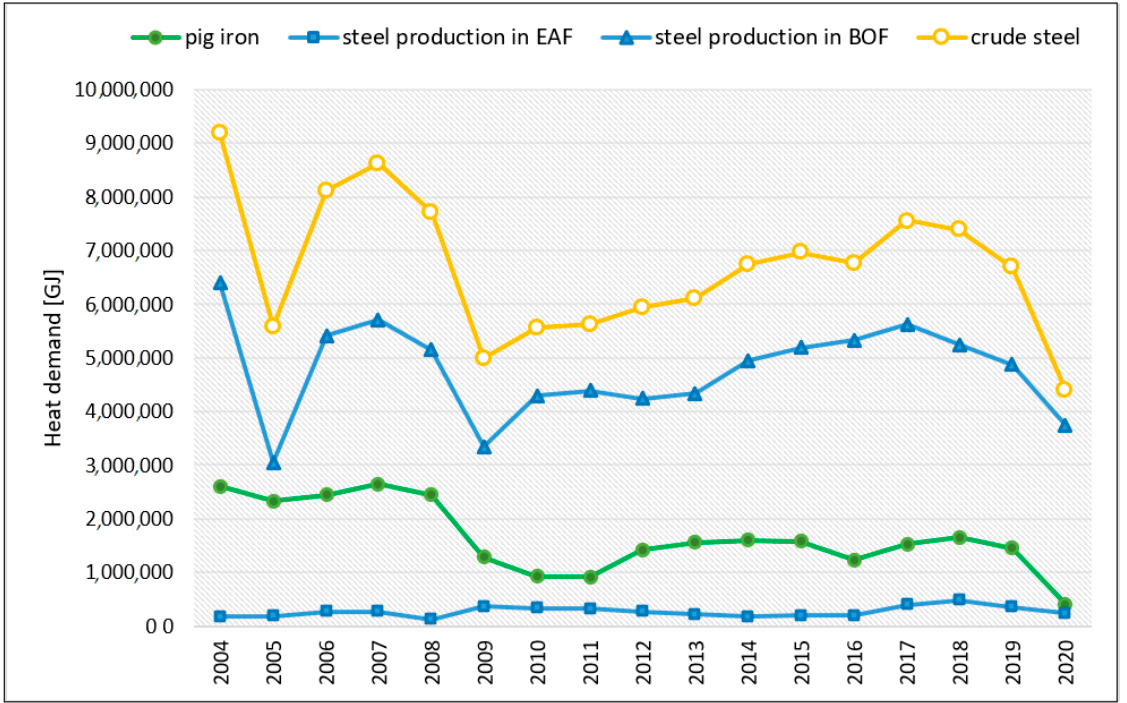
Figure 7. Total heat demand in all of the metallurgical processes in Poland from 2004 to 2020. Source: Own elaboration. Heat intensity for the category: crude steel is the sum of heat intensity for production of pig iron with BOF and EAF.